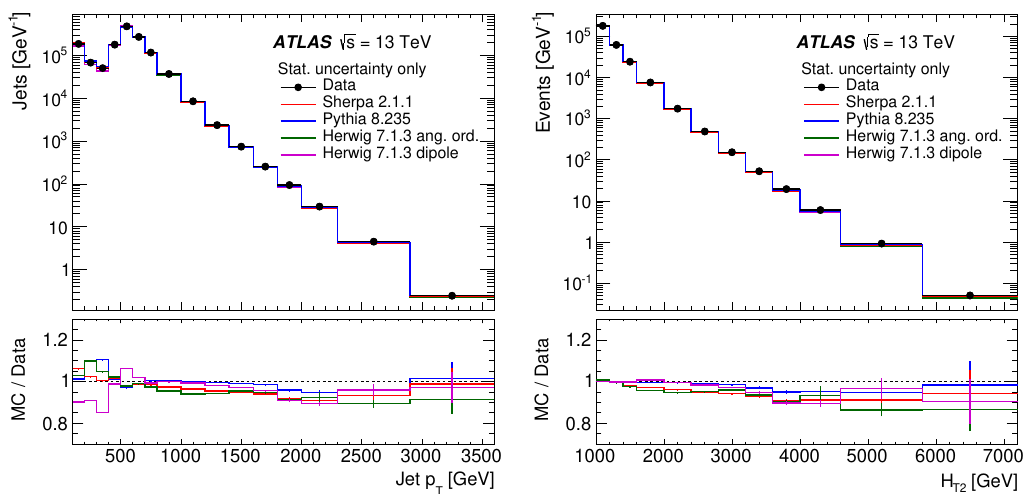
Figure 2 . Detector level distributions of the transverse momenta of all jets (left) and the scalar sum of transverse momenta of the two leading jets (right), together with MC predictions. Only statistical uncertainties are